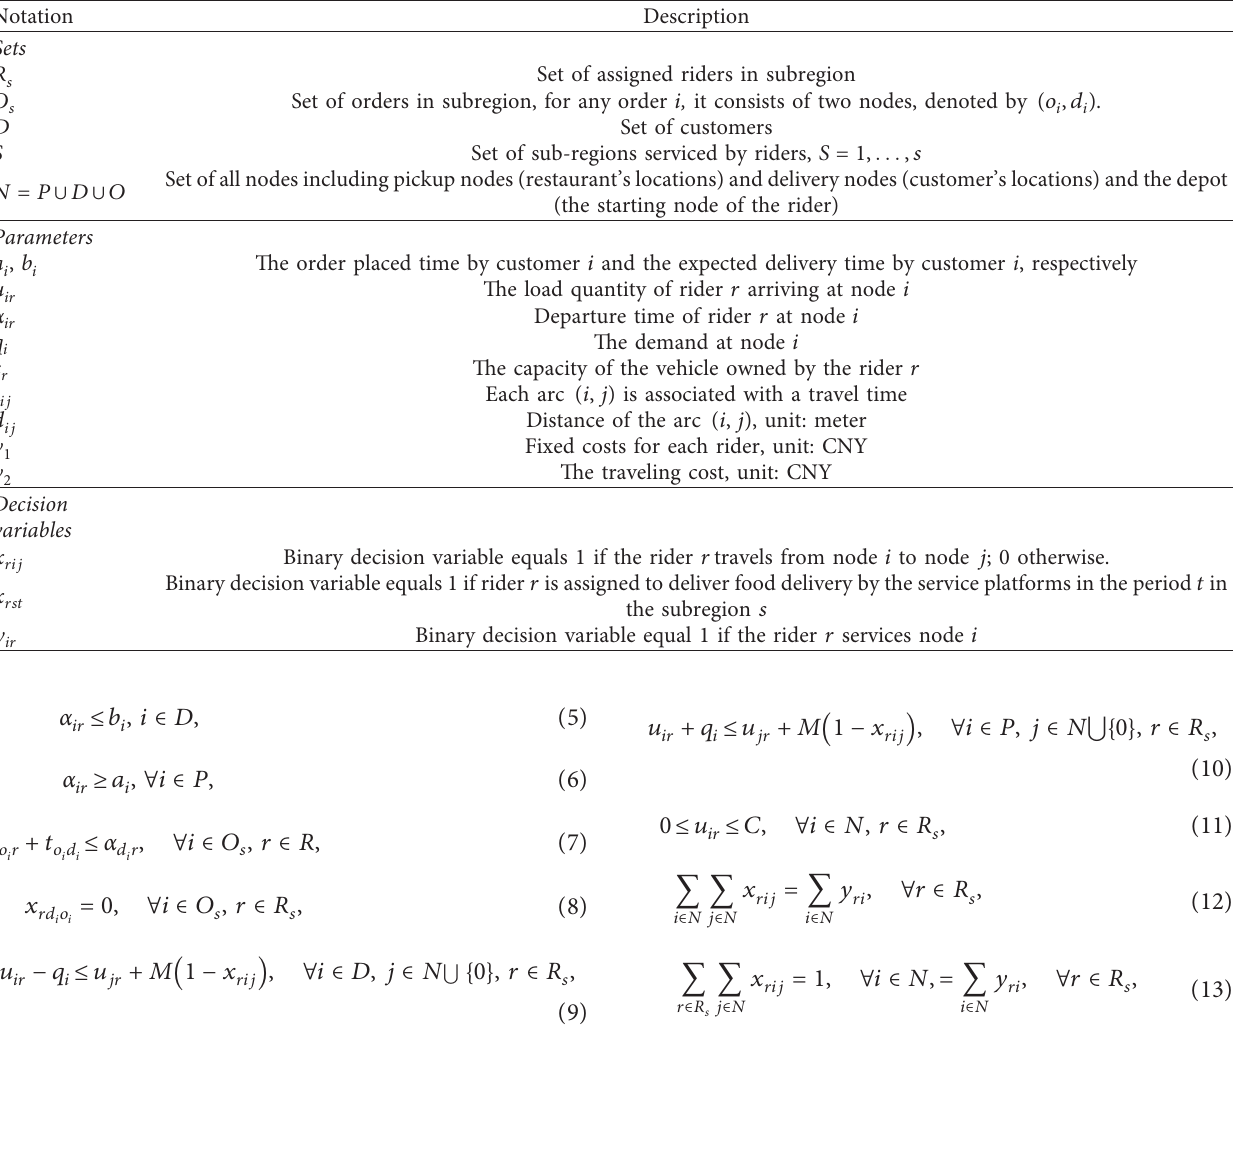
Figure 2: The fluctuation of customer demand with time in a certain service region. Table 2: Sets, parameters, and decision